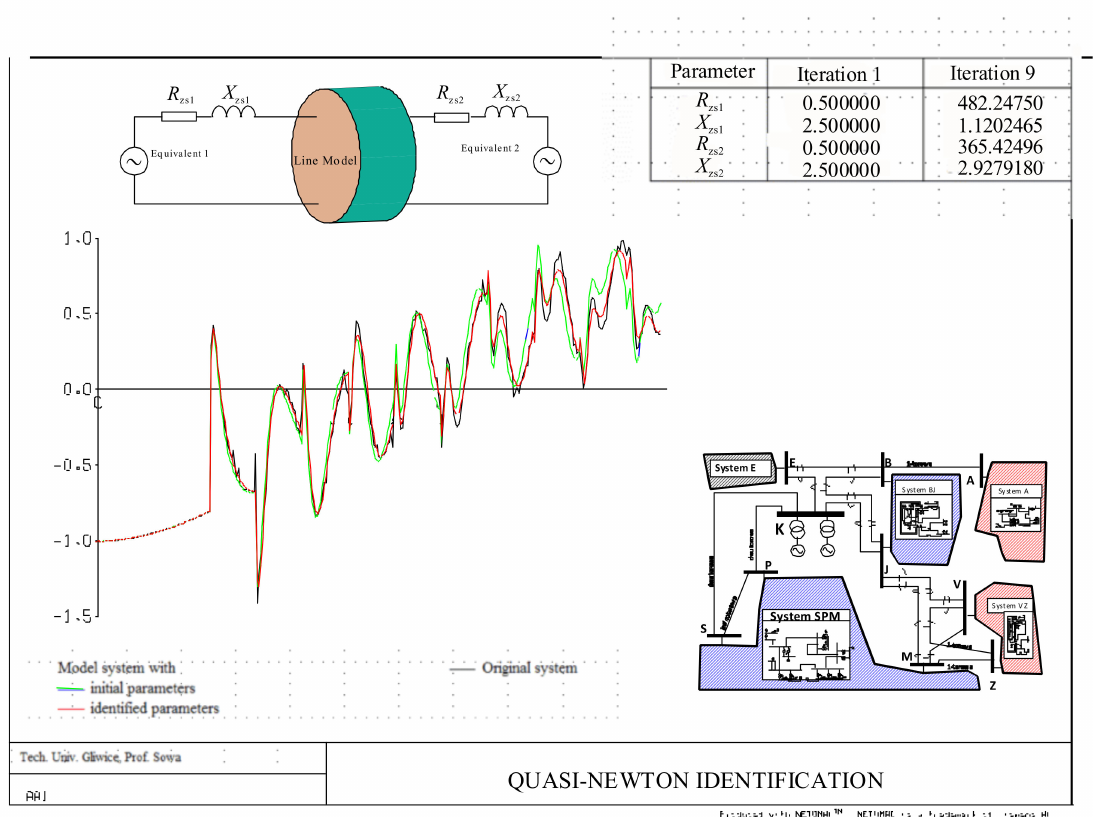
Figure 6. Quasi-Newton parameter